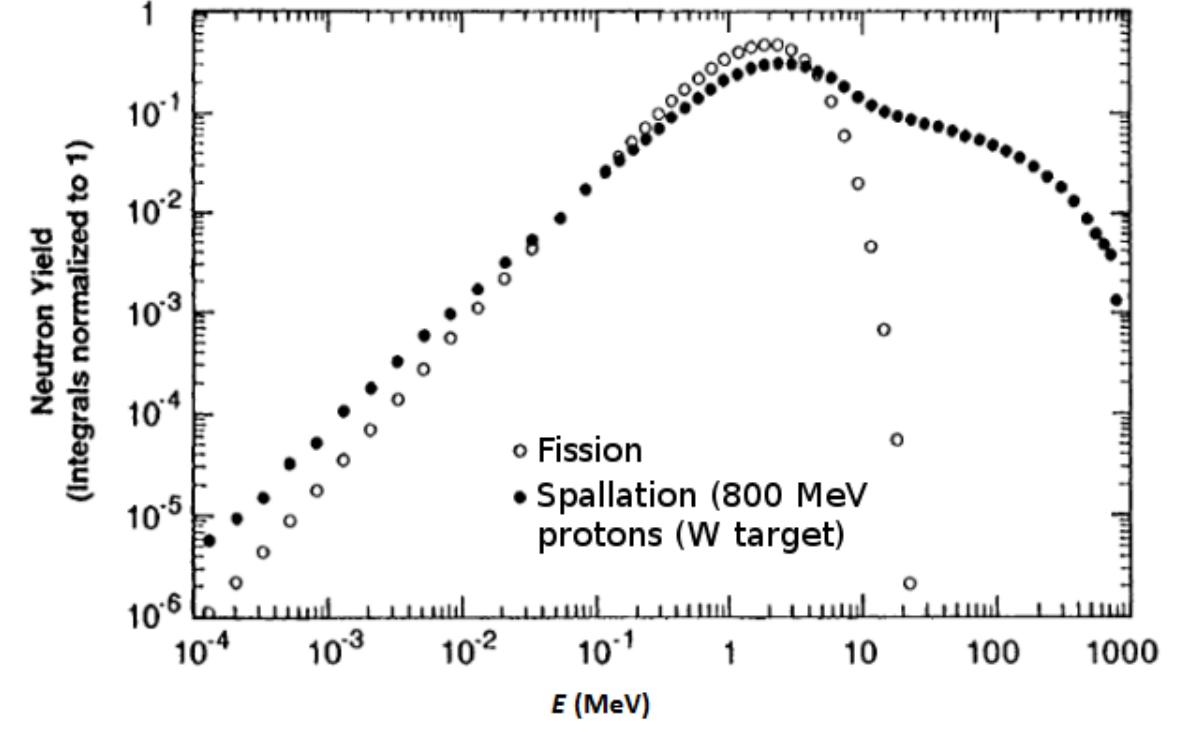
Figure 1. Neutron Yield from fission and spallation inside tungsten target [2]